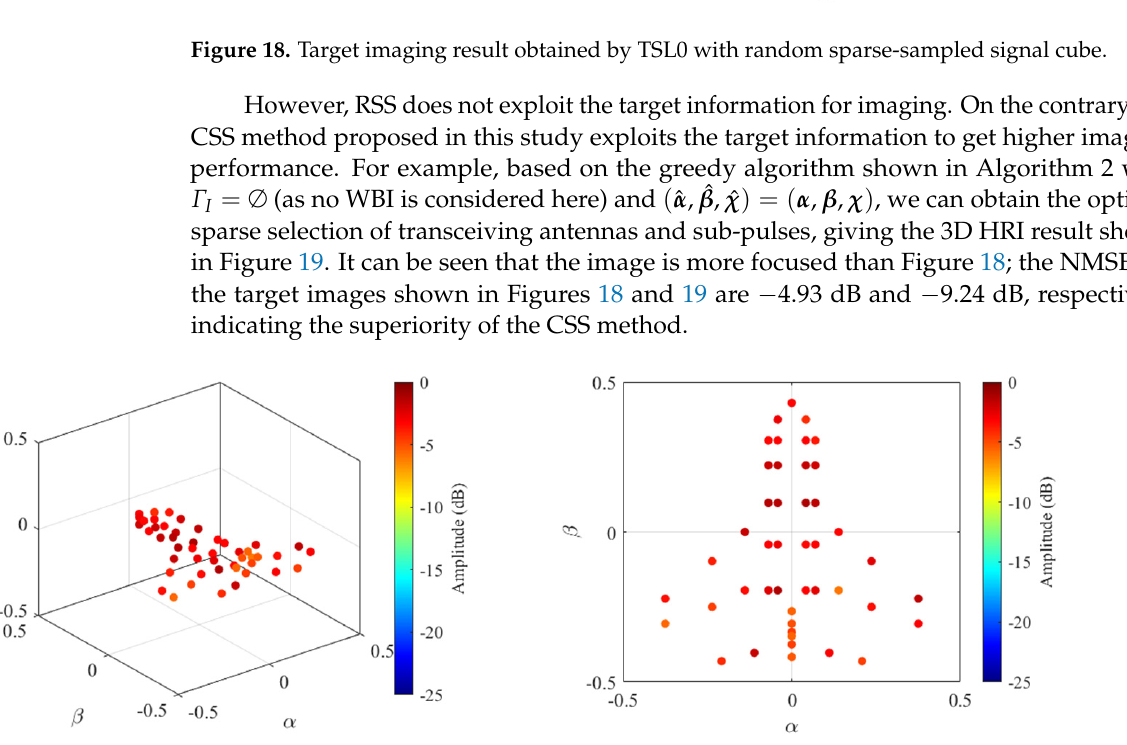
Figure 19. Target imaging result obtained by TSL0 with cognitive sparse-sampled signal cube.